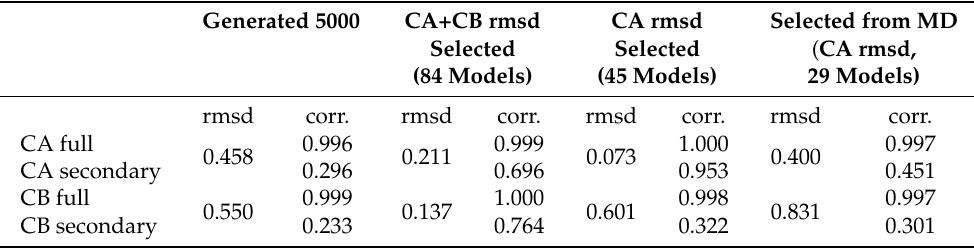
Table 1. RMSD and correlation of the back-calculated chemical shifts of the generated ensembles of the Cd3 (cid:101) segment. Generated 5000 CA+CB rmsd CA rmsd Selected from MD Selected Selected ( CA rmsd, (84 Models) (45 Models) 29 Models) rmsd corr. rmsd corr. rmsd corr. rmsd corr. CA full 0.996 0.999 0.458 0.211 CA secondary